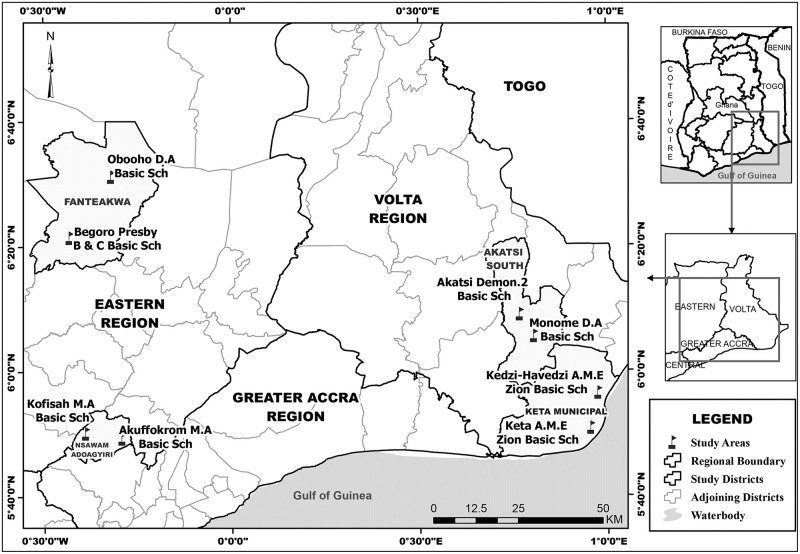
Map showing study districts and schools.